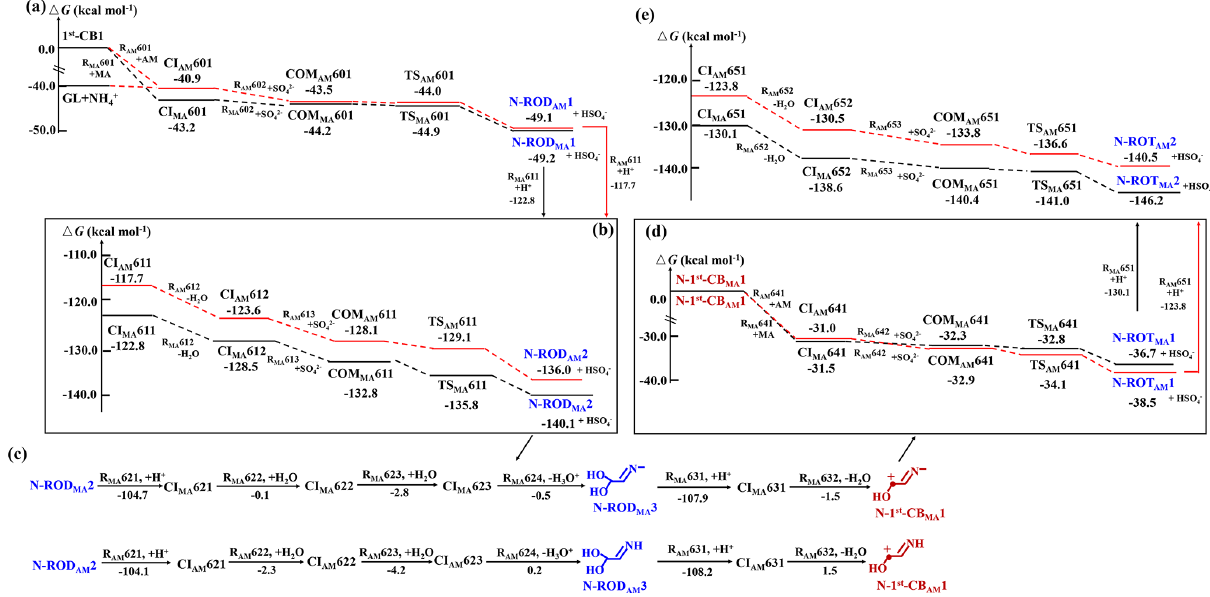
Figure 4. The PES for formation of N-heterocycles starting from (a–b) 1st-CBs with MA / AM to dimers, (c) dimers to N-1st-CBs, and (d– e) N-1st-CBs with MA / AM to trimers (in kcalmol − 1 ). The number denotes the (cid:49)G r or (cid:49)G ‡ for each reaction step, and all energies are relative to the corresponding